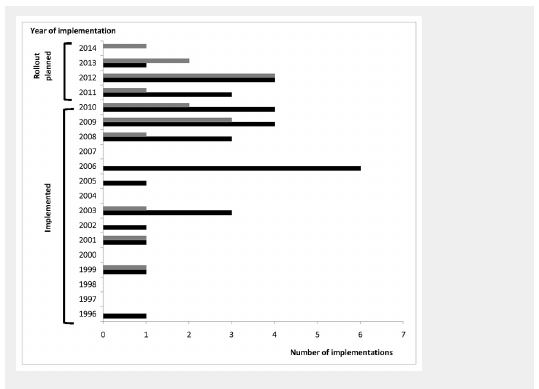
Number of implementations of CPOE and CDSS over the years. Gray bars = implementation of clinical decision support (CDSS) systems; black bars = Implementation of computerised physician order entry (CPOE)